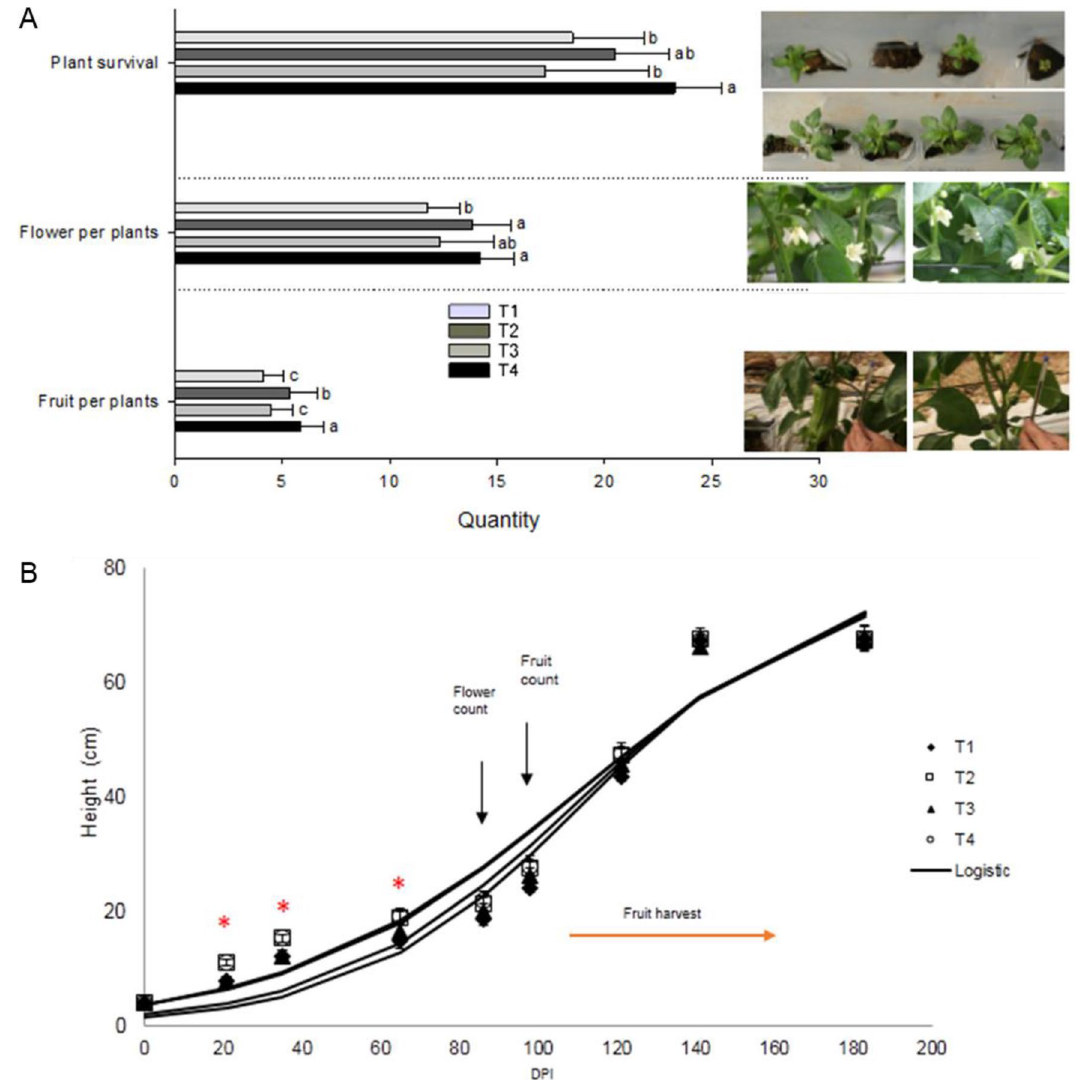
Figure 2. Effect of B. velezensis BBC047 application on bell pepper plants in productive greenhouse. ( A ) Plant survival, flowers and fruit set per plant (N = 40); plant survival evaluated at 57 DPI (3 weeks after transplant) according to ANOVA ( p < 0.05) and Post-Hoc- LSD Fisher test, whereas flowers at 65 DPI and fruit set at 86 DPI were analyzed with Kruskal–Wallis test; photographs by R. Salvatierra-Martinez. ( B ) Growth kinetics of plant height; the model was generated using the average height at different phenological stages: in nursery at 21 and 35 DPI (N = 20); in greenhouse 65 to 183 DPI (N = 40). (*) represents statistical difference between treatments (p <